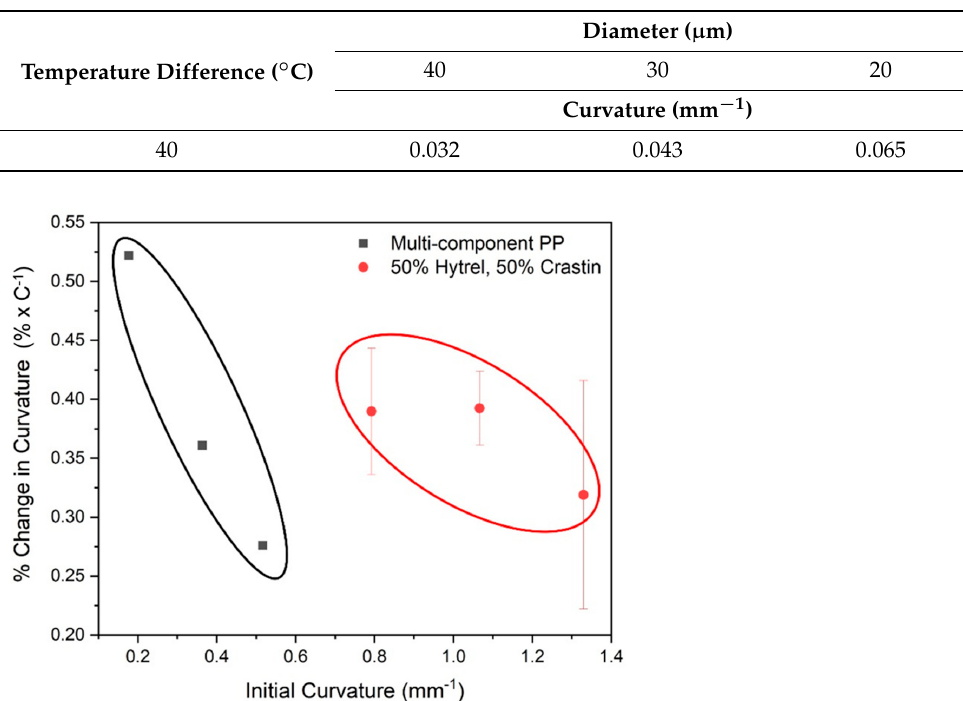
Figure 8. Optical images of fiber curvature change at different temperatures. ( a – c ) display three different fiber samples with repeatable curvature change within the temperature range. Table 4. Predicted Curvature change based on bulk properties as a function of temperature change and fiber diameter.